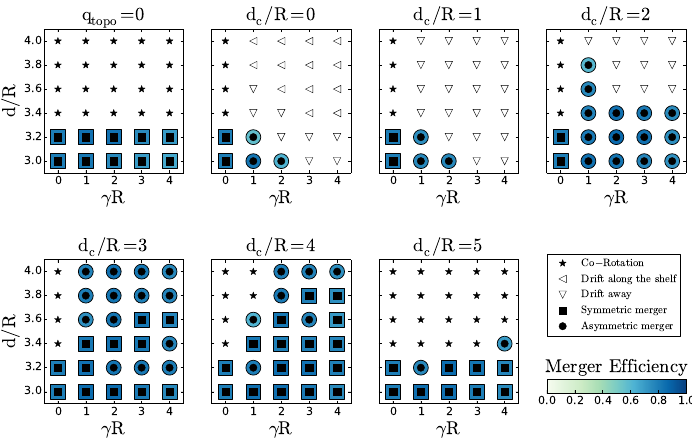
Figure 16. Regime diagram for the interaction of two surface anticyclones, in the ( γ R , d / R ) plane, for fixed d c / R (for each sub-plot). Black stars indicate co-rotation. Black squares for symmetric merger; black circles for asymmetric merger and triangles for vortex drift, away from the slope (triangle pointing down) or along the slope (triangle pointing